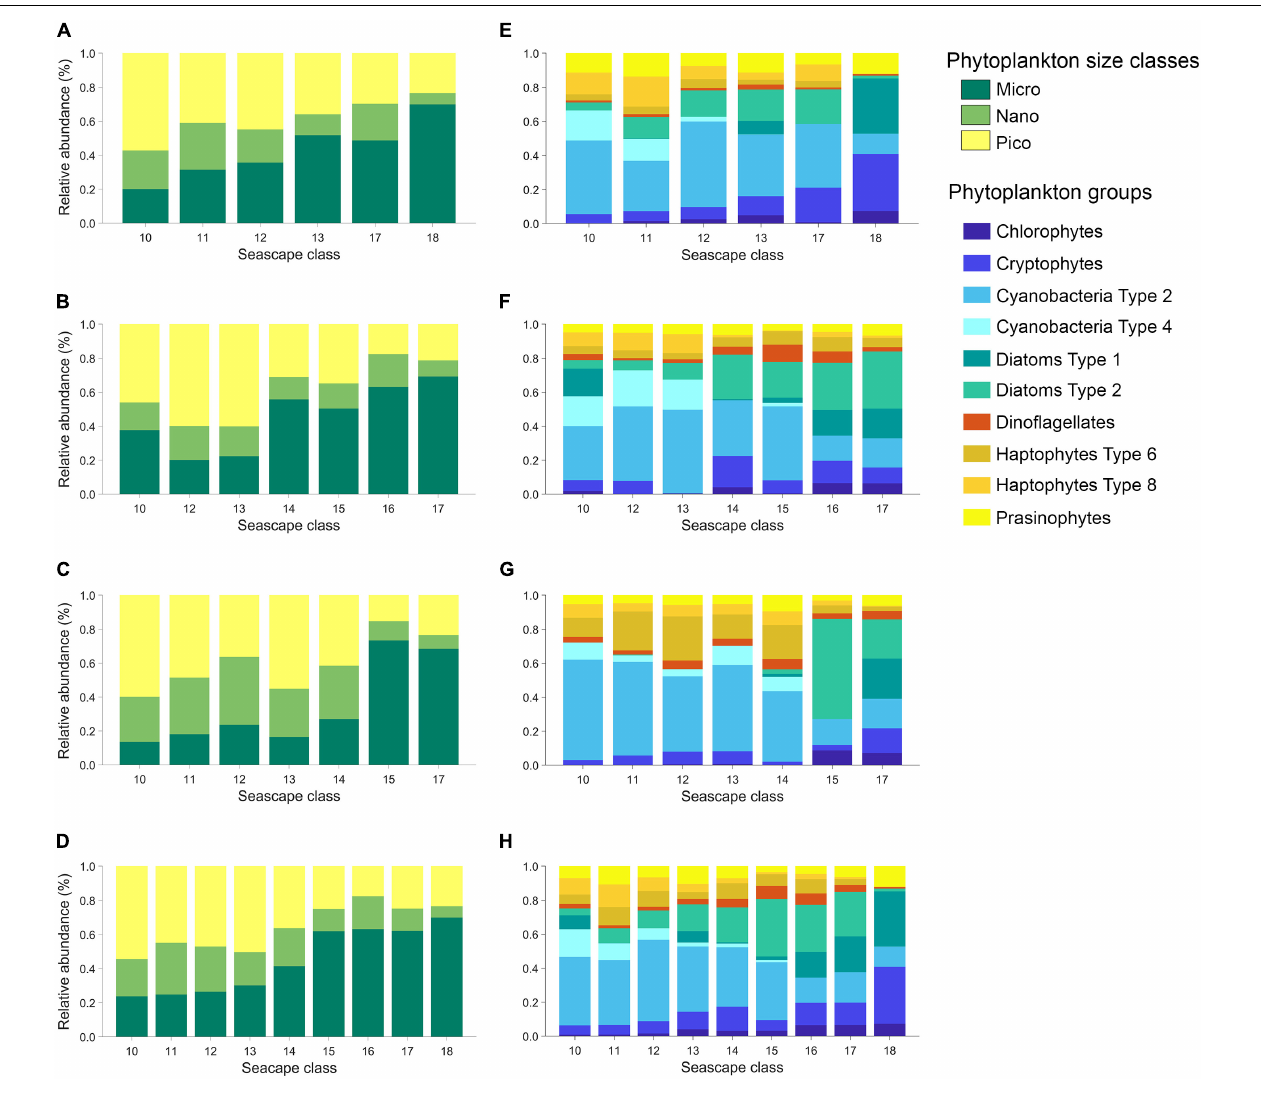
FIGURE 4 | Left: Average contribution of phytoplankton functional types (PFT: micro-, nano-, and pico-phytoplankton) to total chl-a (TChla) derived from diagnostic HPLC pigments using equations described in Uitz et al. (2006) estimated for each seascape class during March, May, and November 2016 cruises (A–C) , and for all the data combined (D) . Right: Average community composition of ten phytoplankton groups estimated for each seascape class derived from CHEMTAX analysis during March, May and November 2016 cruises (E–G) , and for all the data combined (H)